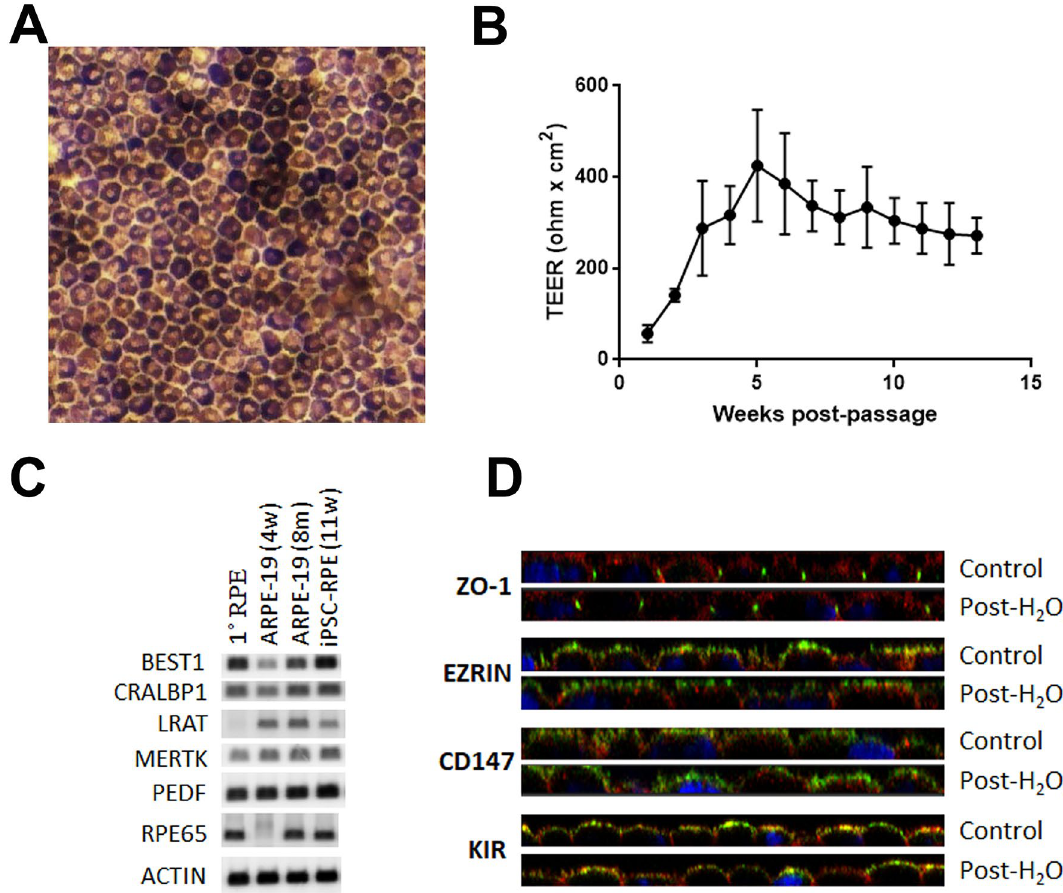
biologic replicates depending on the time point, no technical replicates. Data points show mean ± SD. ( C ) RT-PCR of RPE markers in iPSC-RPE 11 weeks post-passage compared to primary adult human RPE and ARPE19 cells at 4 weeks and 8 months post-passage (uncropped images are shown in Supplementary Fig. 3). ( D ) ICC of iPSC-RPE for ZO-1 at tight junctions, and CD147, Ezrin, and Kir7.1 in the apical membrane. Phalloidin is red and DAPI is blue. Staining is shown both before (control) and after (Post-H 2 O 2 ) exposure to 800 µM H 2 O 2 for 24